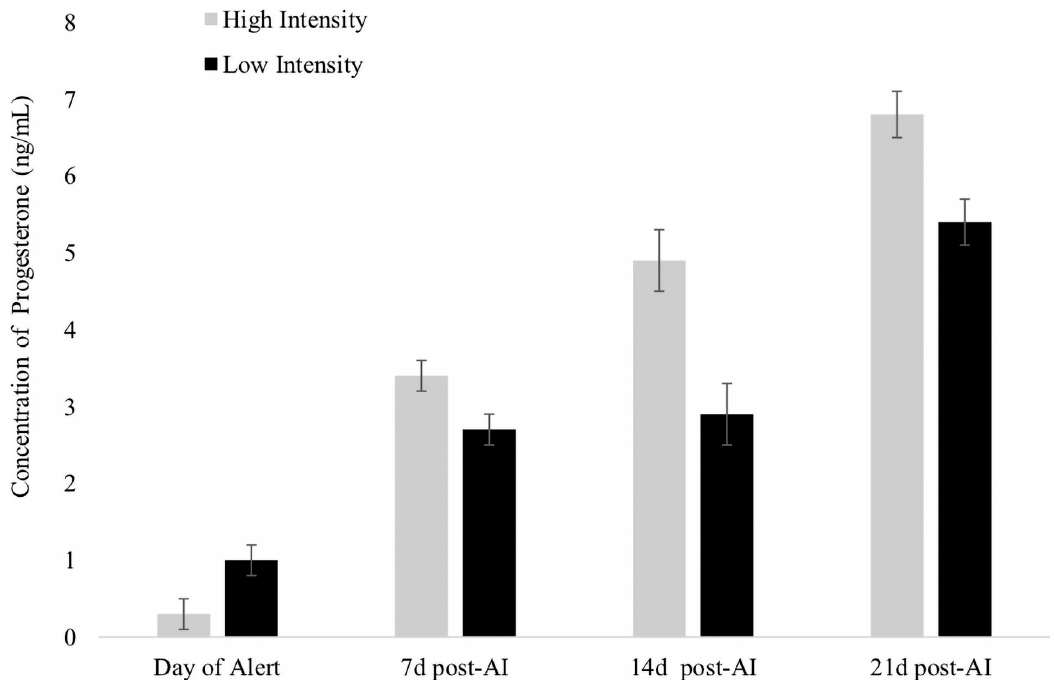
Fig 4. Concentrations of progesterone (least squares means ± SE) on the day of estrus alert (0 d; P < 0.01) and 7 d ( P < 0.05), 14 d ( P < 0.01), and 21 d ( P < 0.01) post-AI relative to estrous expression intensity in Experiment 2. High intensity: estrous expression greater or equal of the median (80.5 index) of the automated activity monitor. Low intensity: estrous expression less than the median.